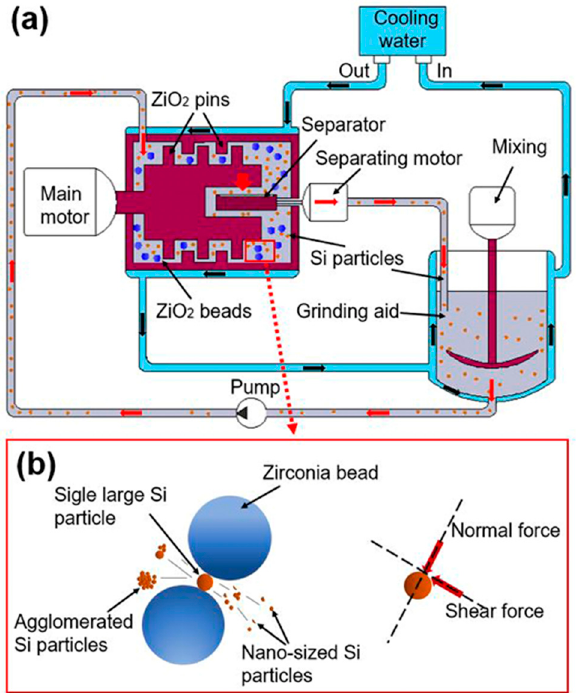
Figure 2. ( a ) Schematic view of bead milling system and ( b ) illustration of the working area. The state of the Si micro/nanoparticles prepared by spark erosion will affect the re- sults after bead milling [27,28]. The micro/nanoparticles Si L and Si S prepared with long and short pulse durations were bead milled for 8 h with the same parameters to obtain nanoparticles Si L+M and Si S+M . At the same time, in order to verify the effect of bead milling time parameters on the degree of amorphization, a set of control experiments for Si S bead milling for 12 h was added to obtain Si S+MM . The operation conditions are listed in Table 2. Table 2. The specific parameters of bead milling.